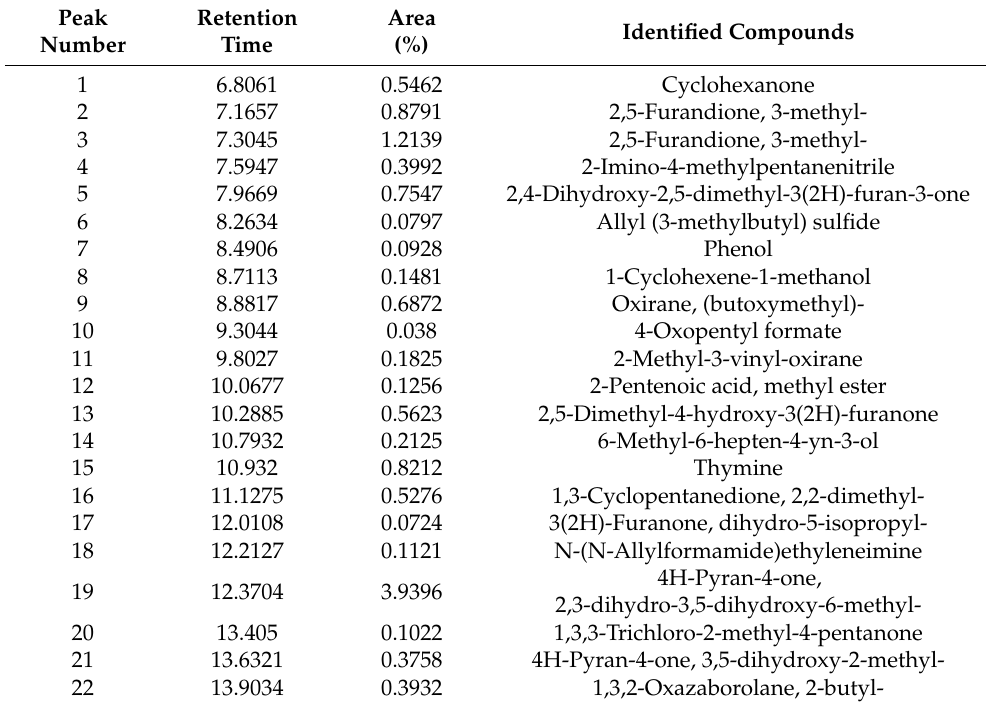
Table 2. Chemical compounds identified in PPE via GC-MS